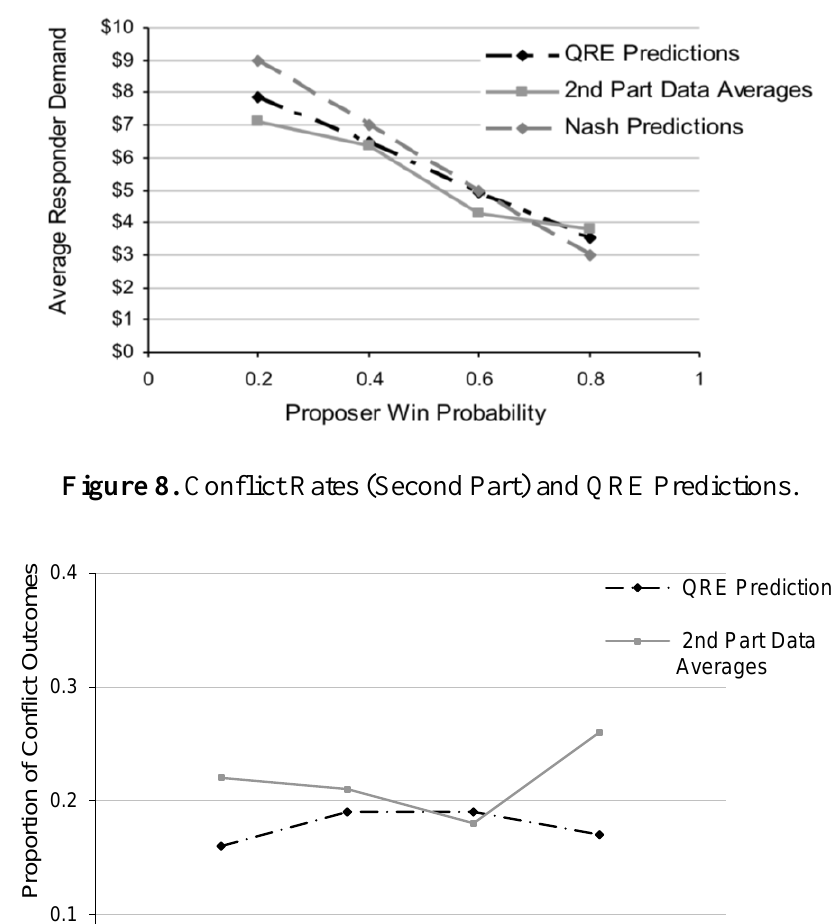
Figure 7. Average Responder Demands (Second Part) and QRE Predictions.